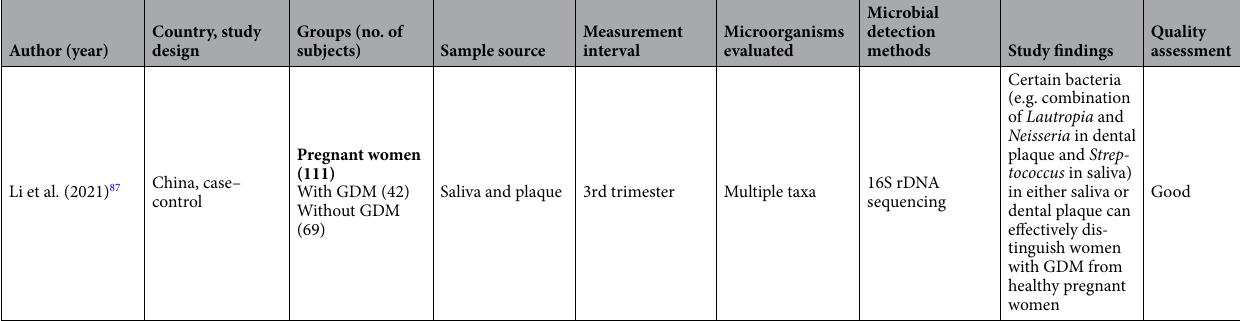
Table 6. Impact of gestational diabetes mellitus (GDM) on oral microorganisms during